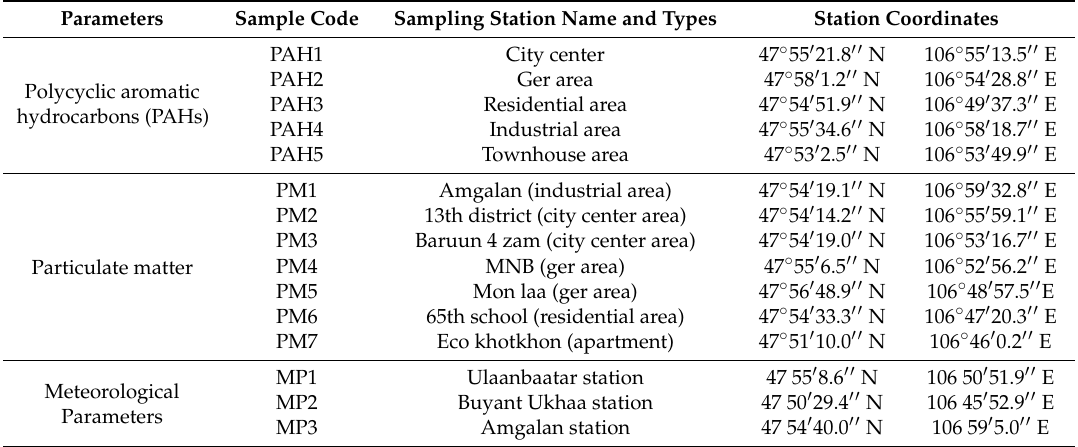
Figure 1. Sampling sites in Ulaanbaatar City, Mongolia. Boundaries in the lower panels show municipal districts ( düürgüüd ) within Ulaanbaatar City. Table 1. Sampling station locations in the Ulaanbaatar City,